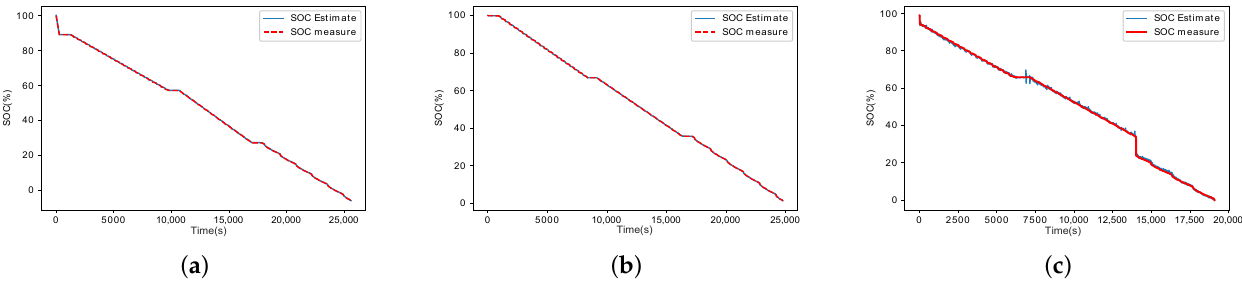
Figure 10. SOC estimation based on DST and FUDS test with RoLSTM for: ( a ) − 10 ◦ C; ( b ) 50 ◦ C; and ( c ) different ambient temperature.